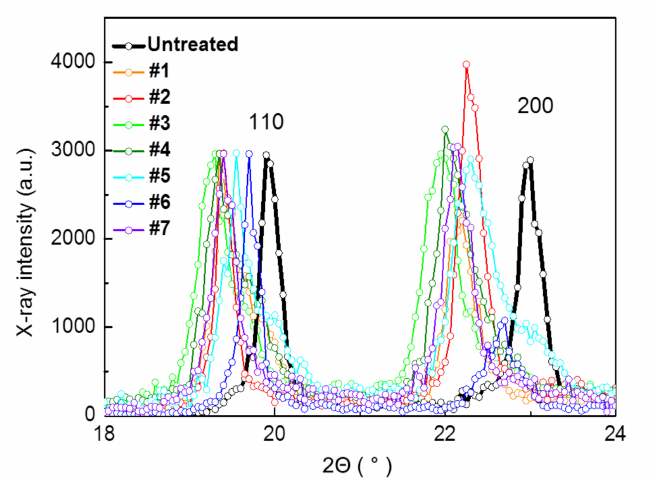
Figure 7. {110} and {200} XRD reflections of 316 L steel prepared by L-PBF before and after plasma treatments. After plasma treatments, the peaks shift towards lower angles due to the expansion of austenite